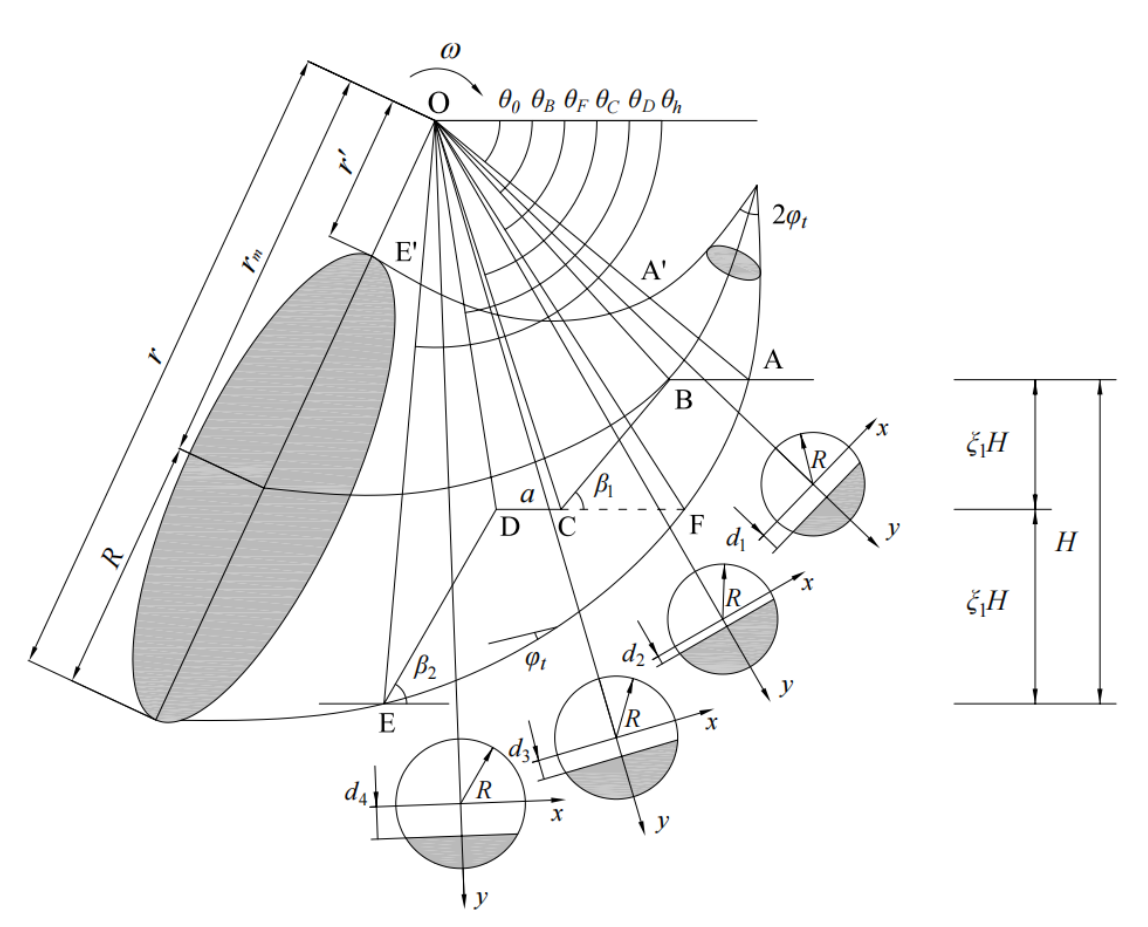
Figure 2. The 3D horn-like rotational failure mechanism for the 3D two-step slope .